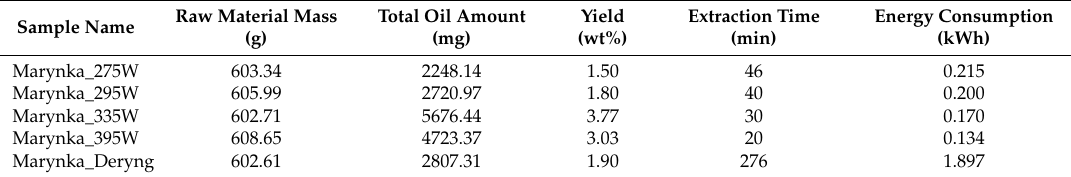
Table 4. The results for Marynka extract essential oils microwave-assisted